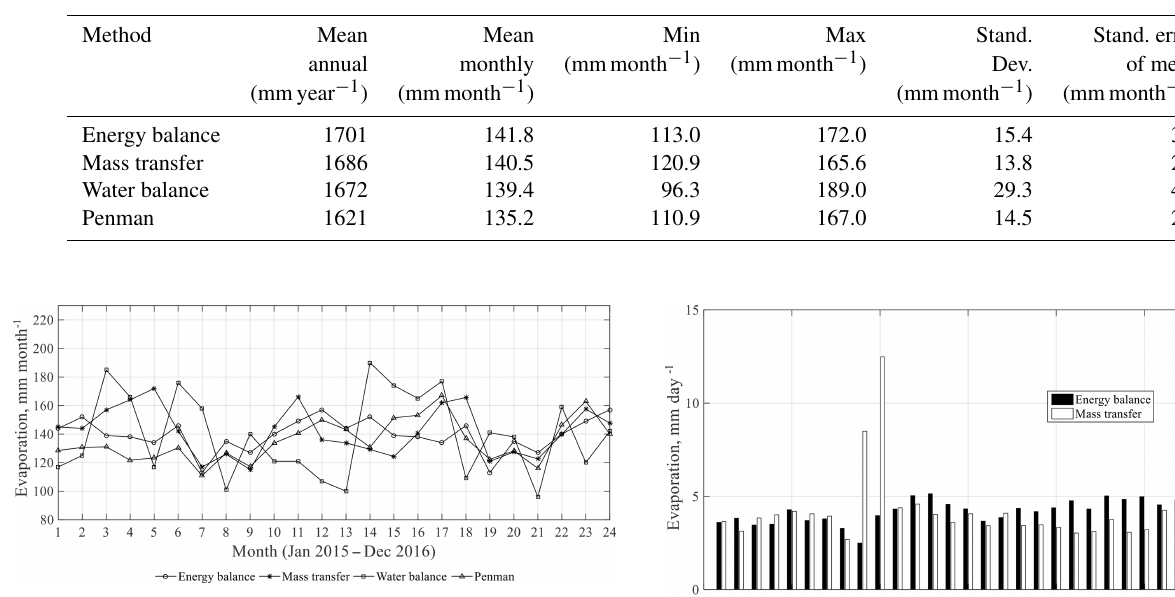
Figure 9. Monthly actual evaporation calculated by the four meth- ods for the period from January 2015 to December 2016.